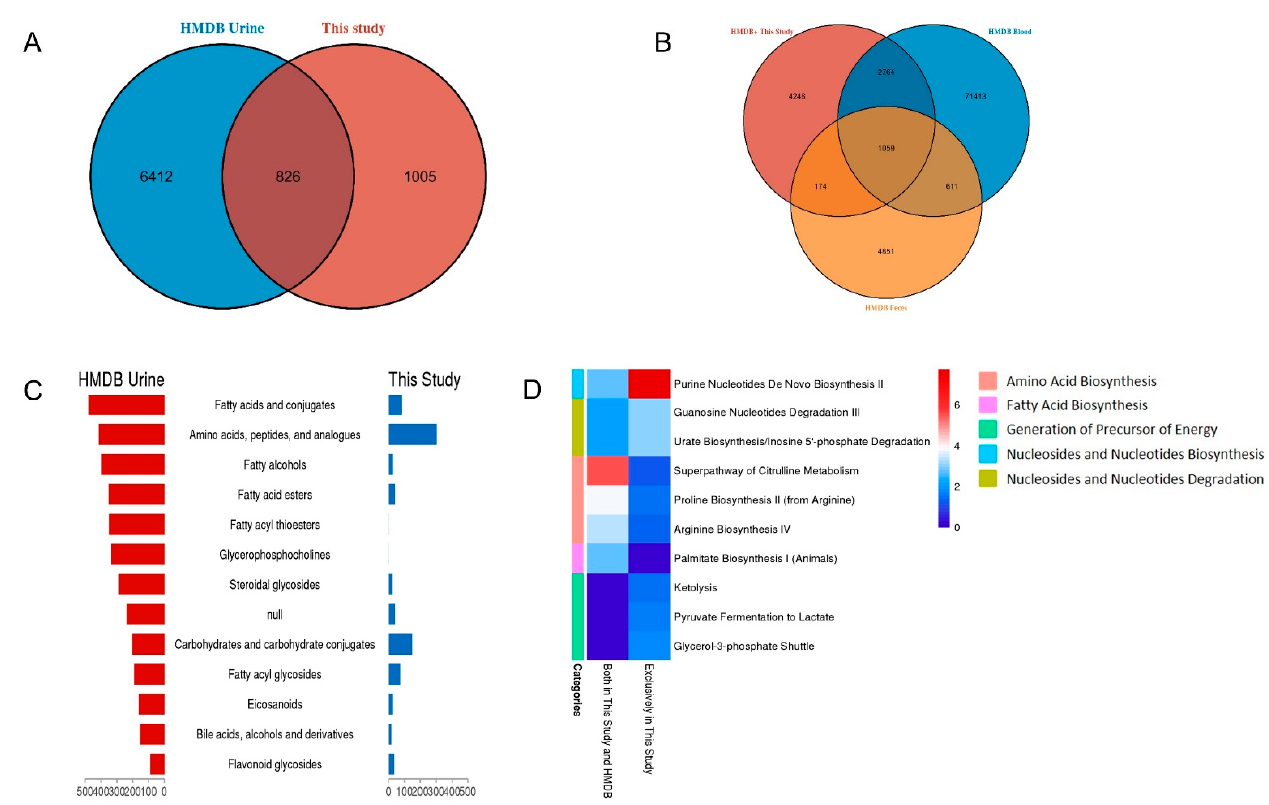
Figure 3. Comparison between this study and HMDB. ( A ) The overlap of this study and HMDB. ( B ) Comparison of the combined urine database with HMDB blood and fecal database. ( C ) The top sub class of annotated metabolites in this study and HMDB. ( D ) Pathway comparative analysis of this study and HMDB.